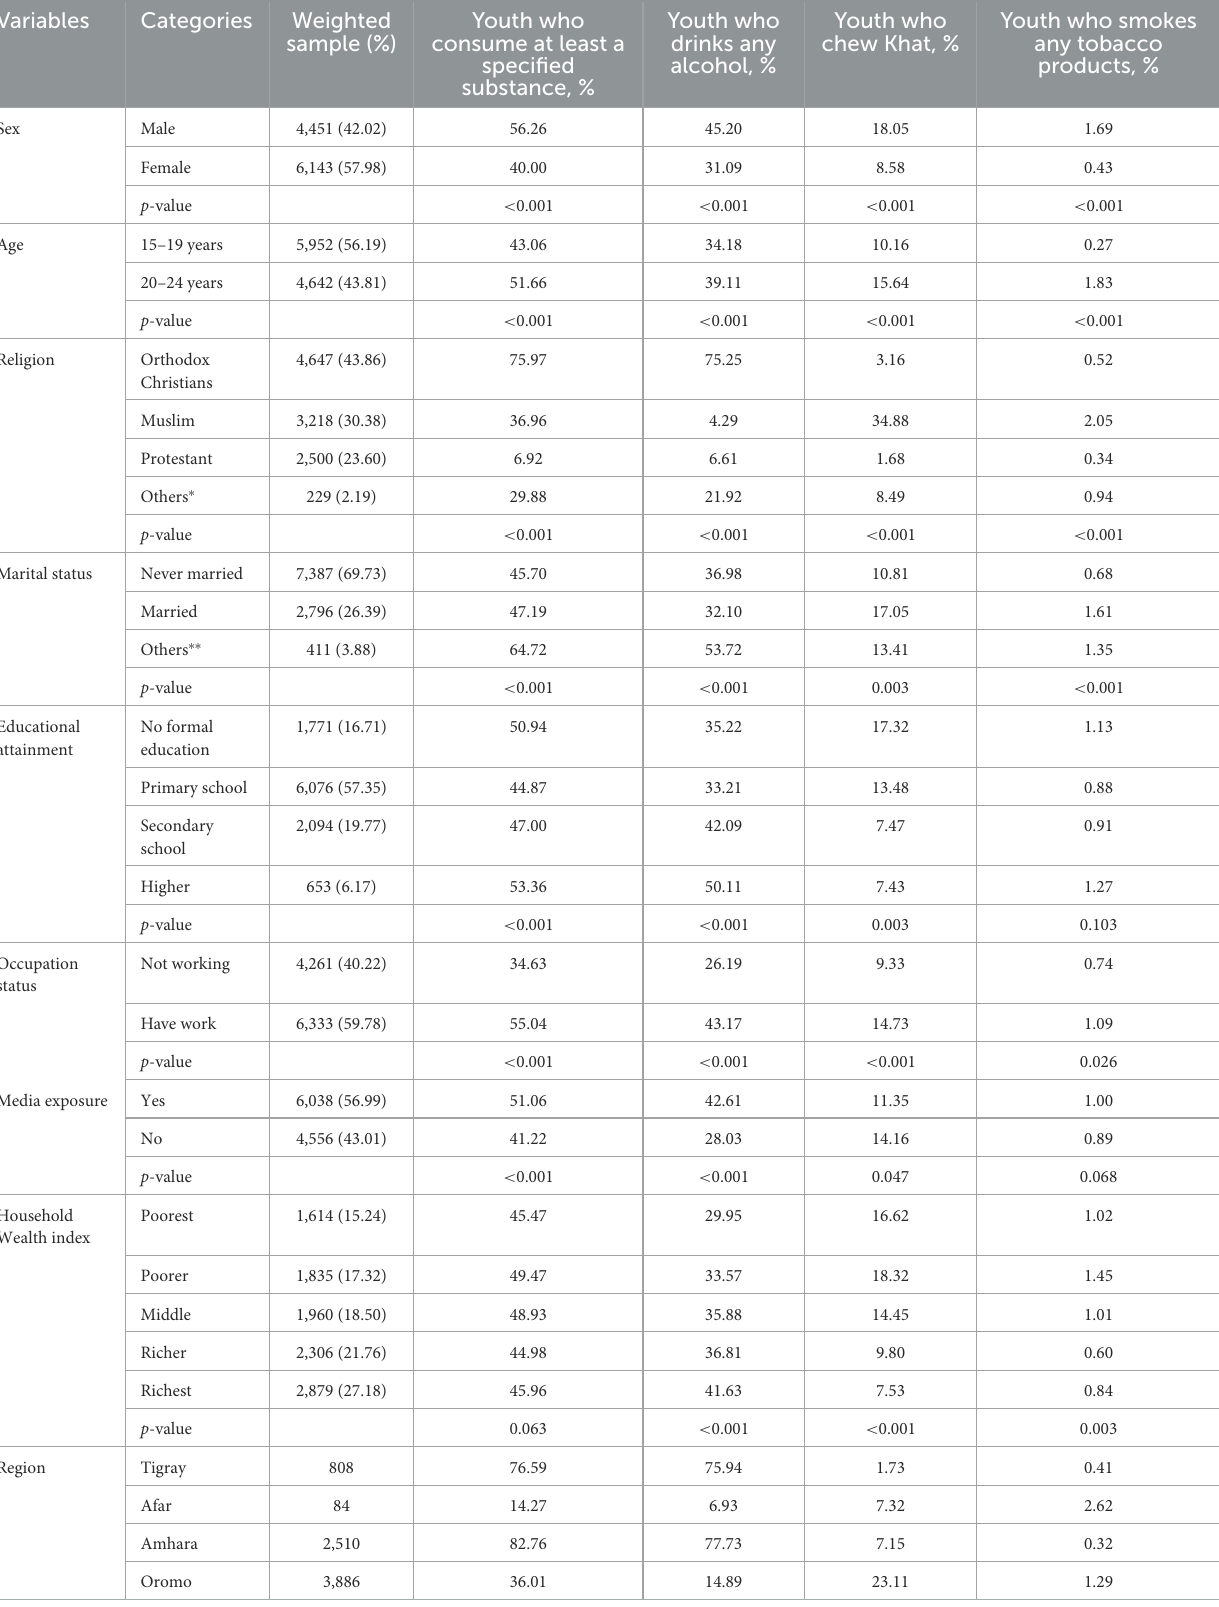
TABLE 1 Descriptive statistics of substance use by the youth according to the 2016 EDHS data (weighted data =